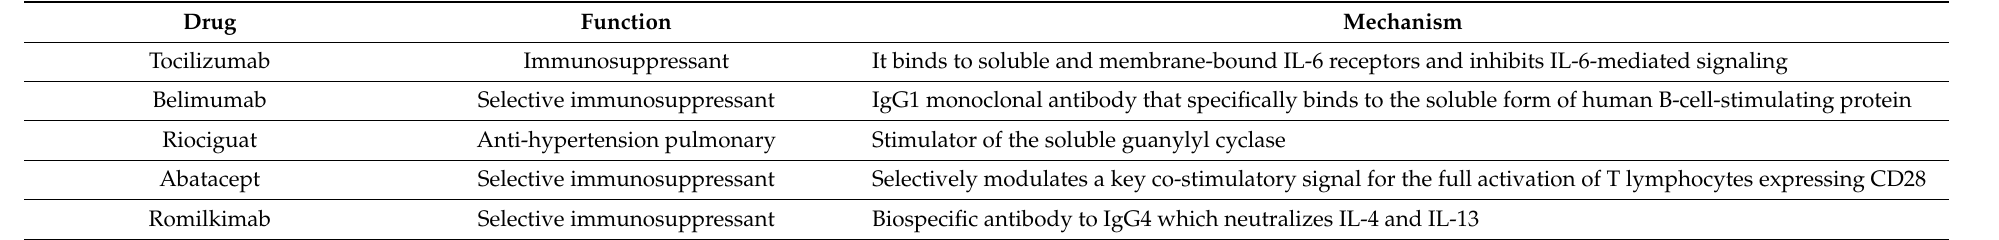
Table 4. Function and mechanism of the biological drugs used for the treatment of systemic sclerosis (SSc) included in this systematic review.